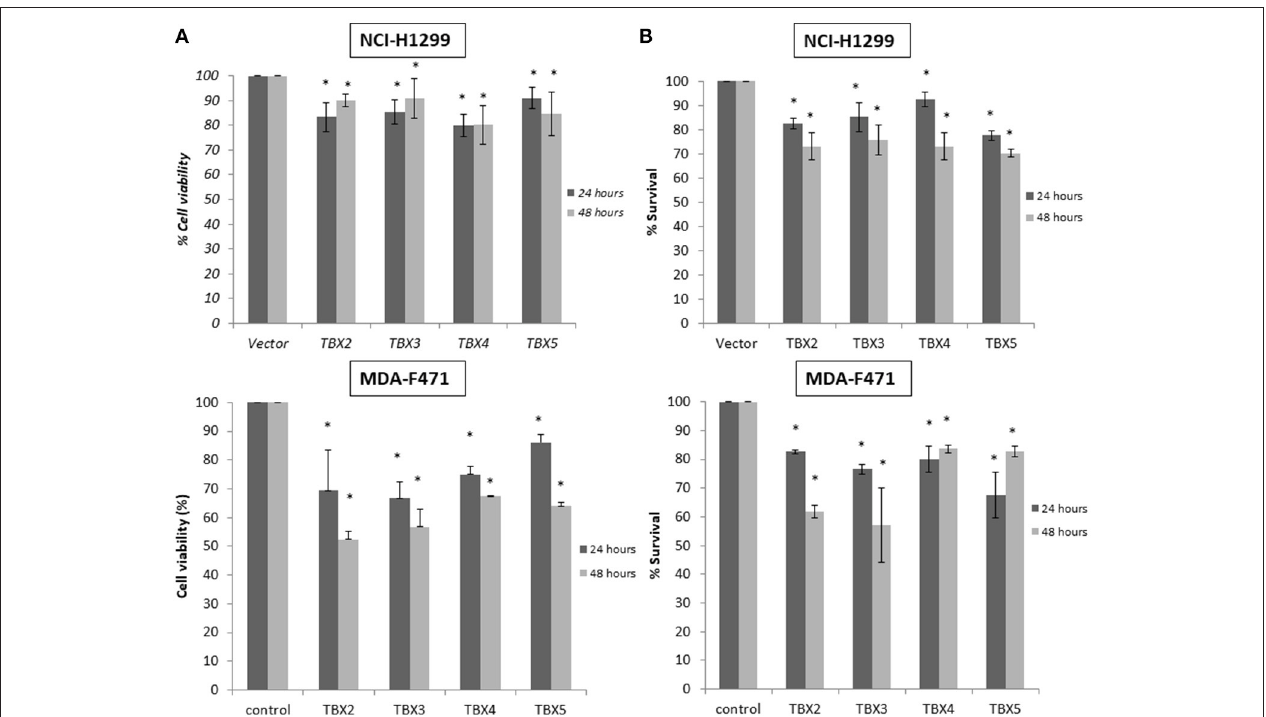
FIGURE 3 | Cell viability and proliferation assays for cells overexpressing TBX2 members. Trypan blue exclusion analysis (A) and MTT assay (B) show a similar proportional reduction in cell viability with TBX2-5 transfection as compared to control in both NCI-H1299 and MDA-F471 cells. Experiments were performed at least 3 times and results are presented as the mean ± SD and are statistically (*) significant for p <